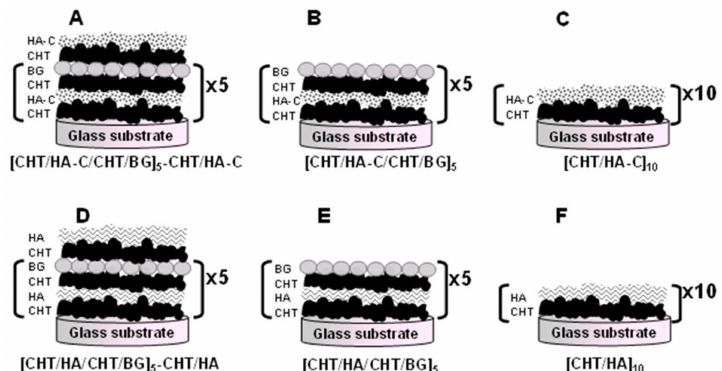
Figure 13. Schematic of the multilayer film configuration of ( A ) condition 1, [CHT / HA-C / CHT / BG] 5 - CHT / HA-C; ( B ) condition 2, [CHT / HA-C / CHT / BG] 5 ; ( C ) condition 3, [CHT / HA-C] 10 ; ( D ) control 1, [CHT / HA / CHT / BG] 5 -CHT / HA; ( E ) control 2, [CHT / HA / CHT / BG] 5 ; and ( F ) control 3, [CHT / HA] 10 . Reproduced with permission from Ref. [128], Copyright 2015, American Chemical Society.